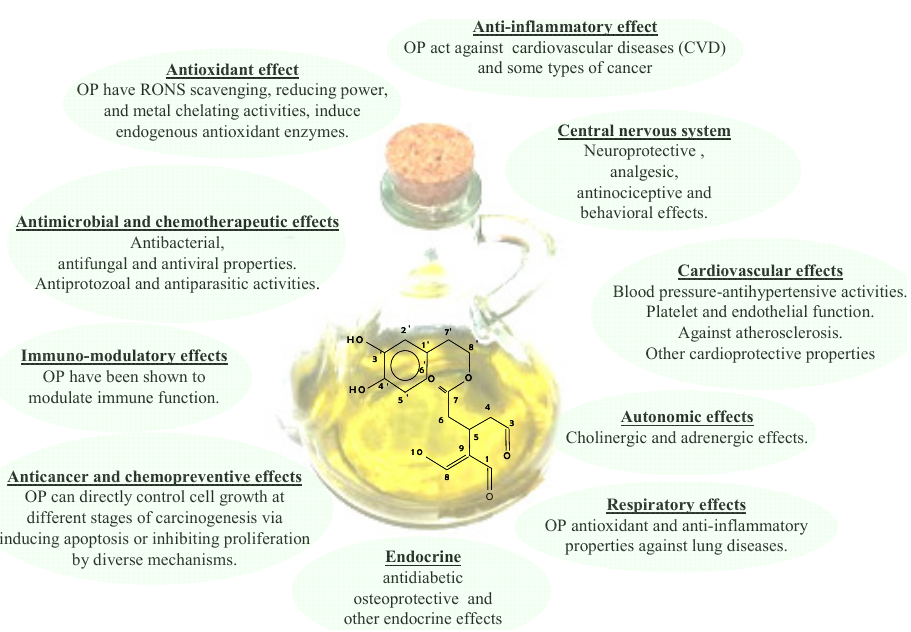
Figure 2. Healthy properties of